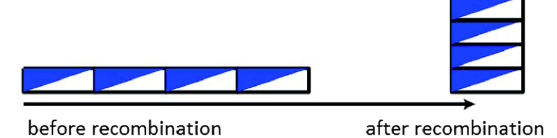
FIG. 11. Depiction of train errors ’ overlap. The blocks on the left and right represent the trains before and after the recombi- nation, respectively. After the recombination the error functions of the trains overlap.